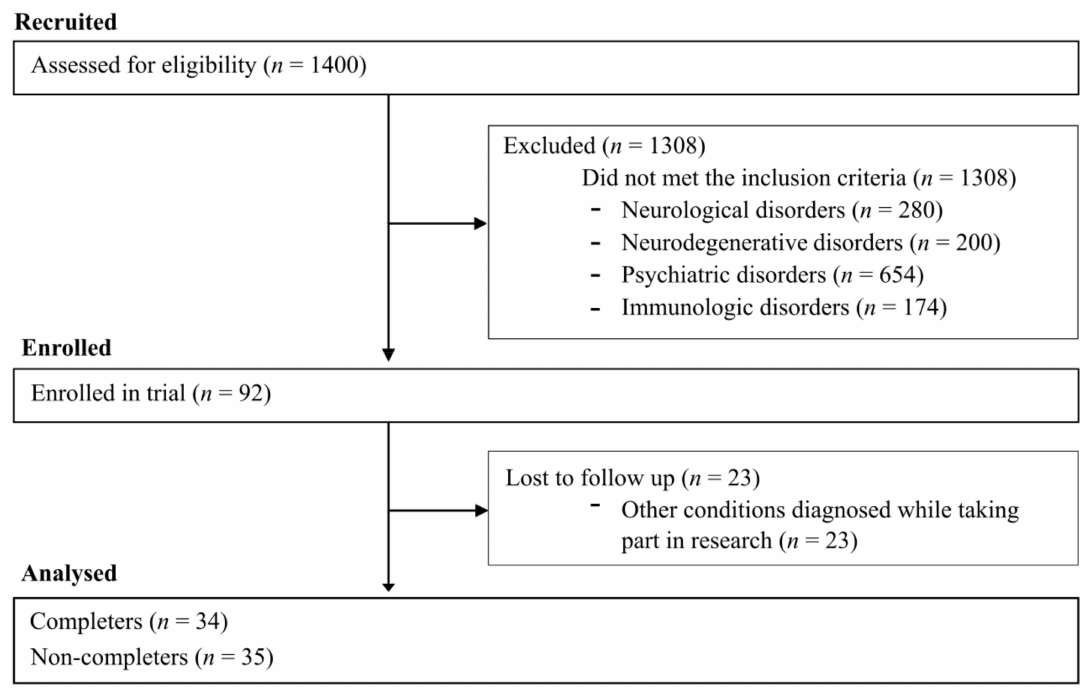
Figure 1. CONSORT-type flow